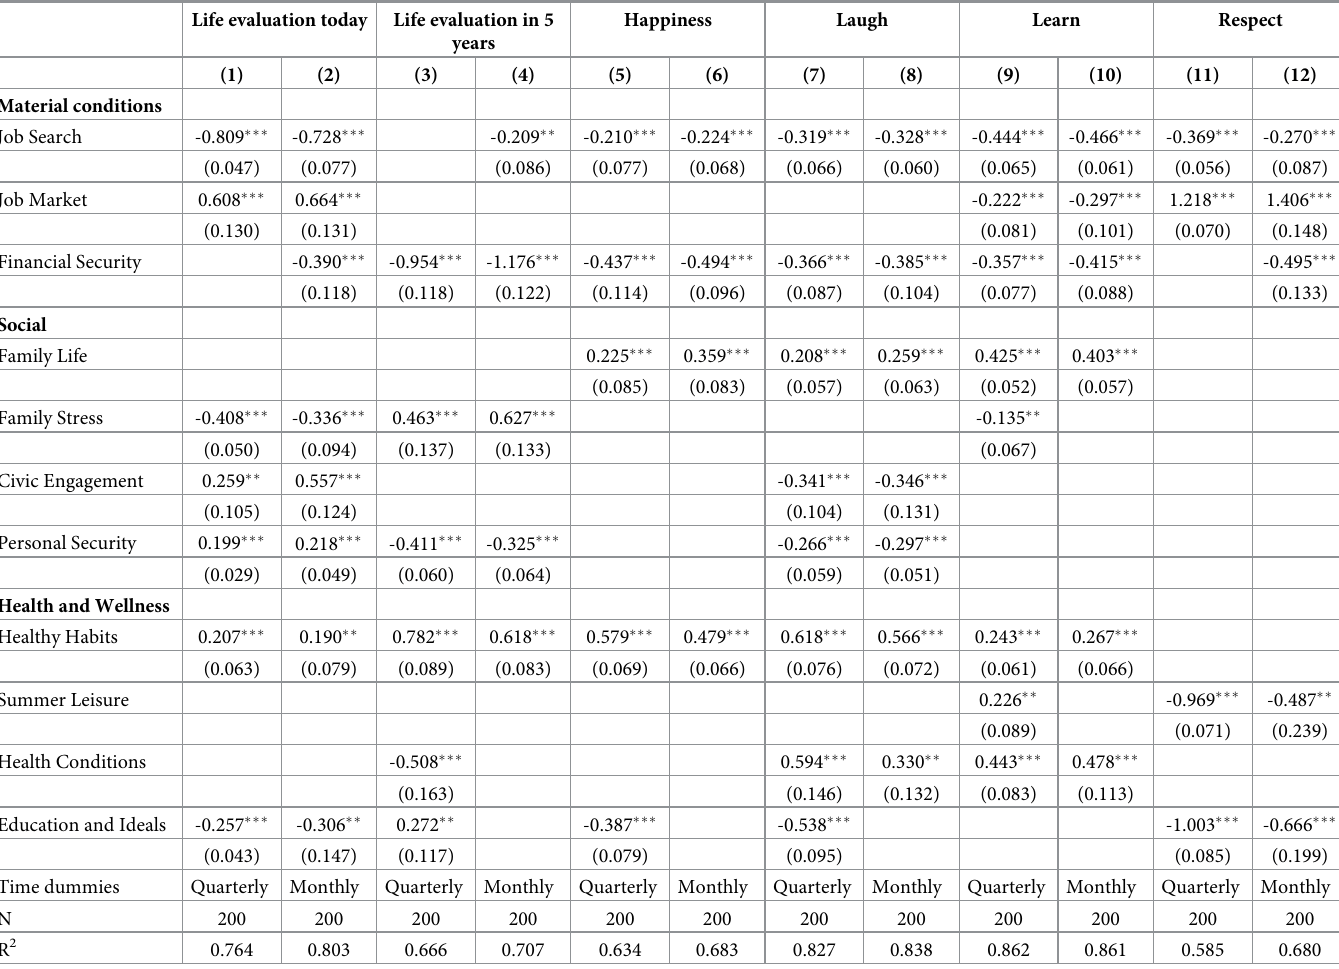
Table 1. Regression of categories on subjective well-being data–life evaluation and positive affects (national level). Life evaluation